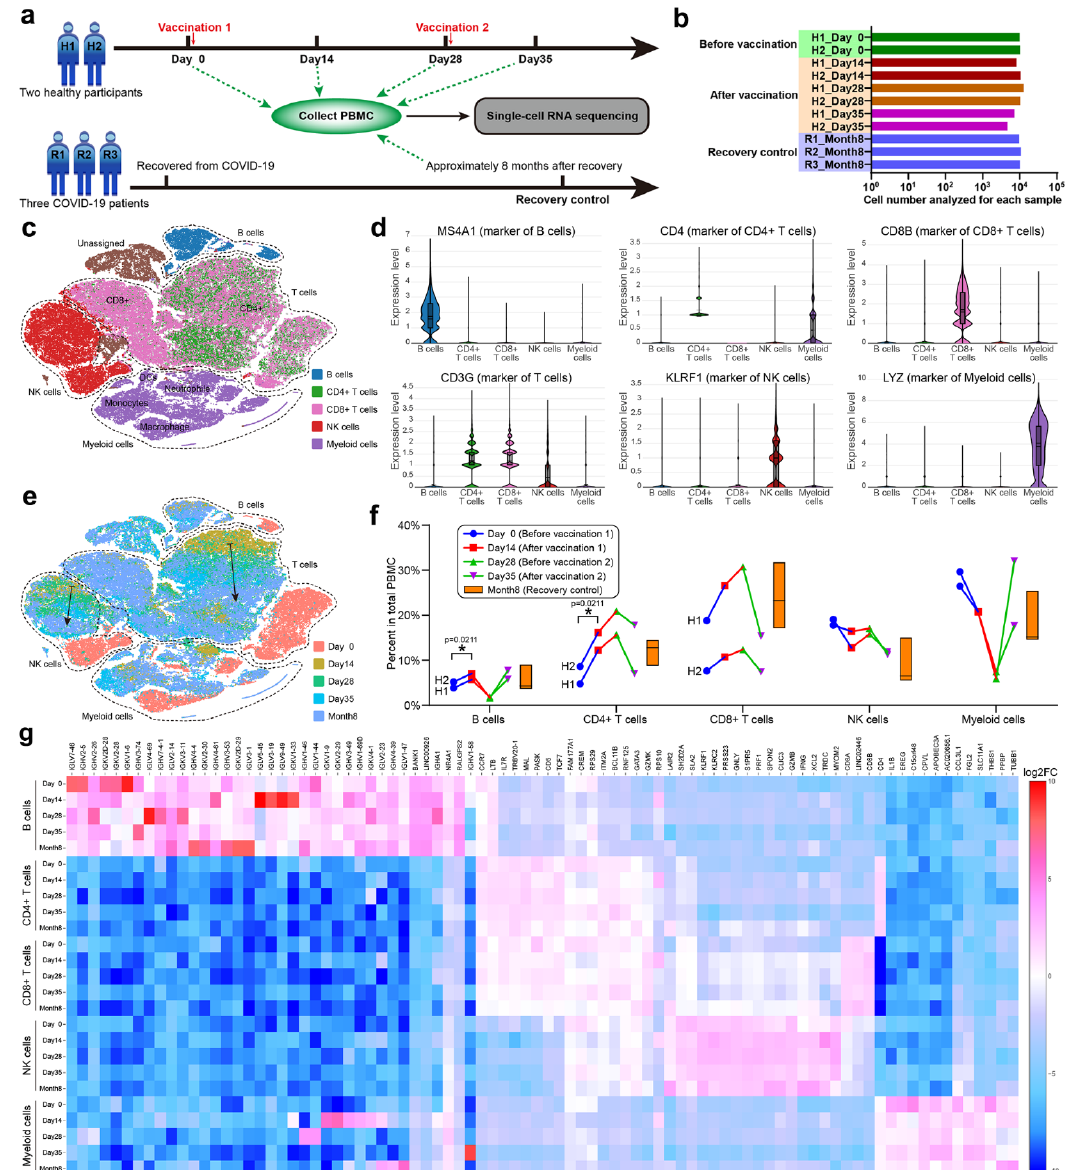
Figure 4. scRNA-seq of PBMC. ( a ) Group design and timeline for scRNA-seq of PBMCs. Eleven samples from five randomly chosen adult participants (H1, H2, R1, R2 and R3) were used for scRNA-seq. Two healthy participants were vaccinated with two doses of CoronaVac (3 μg) after collecting blood samples at Day 0 and 28. Three COVID-19 recovered participants were enrolled. PBMCs were isolated from 11 blood samples and sent for scRNA-seq. ( b ) The total cell number analyzed for each sample. ( c ) The main immune cell types in the isolated PBMCs. B cells, CD4+ T cells, CD8+ T cells, NK cells, and myeloid cells were identified by their gene markers and colored on the t-SNE plot. ( d ) Violin plots of representative gene marker expressions. ( e ) The t-SNE plot colored by the observation time. The dashed lines indicate clusters of four main cell types, and the two solid arrows indicate gradual transitions from Day 14 to 28, Day 35 of vaccination groups, and Month 8 of the recovery controls. ( f ) Percent of each cell type in the total PBMCs. The floating bars represent min, median, and max for the three participants in the recovery group. The symbols with connecting lines indicate multiple timepoints for the two participants in the vaccination group. Two-way RM ANOVA and Tukey’s multiple comparisons test were performed for the vaccination group. * p < 0.05. ( g ) A heatmap showing the expression of significant genes for the 25 subclusters generated by crossing cell types and observation